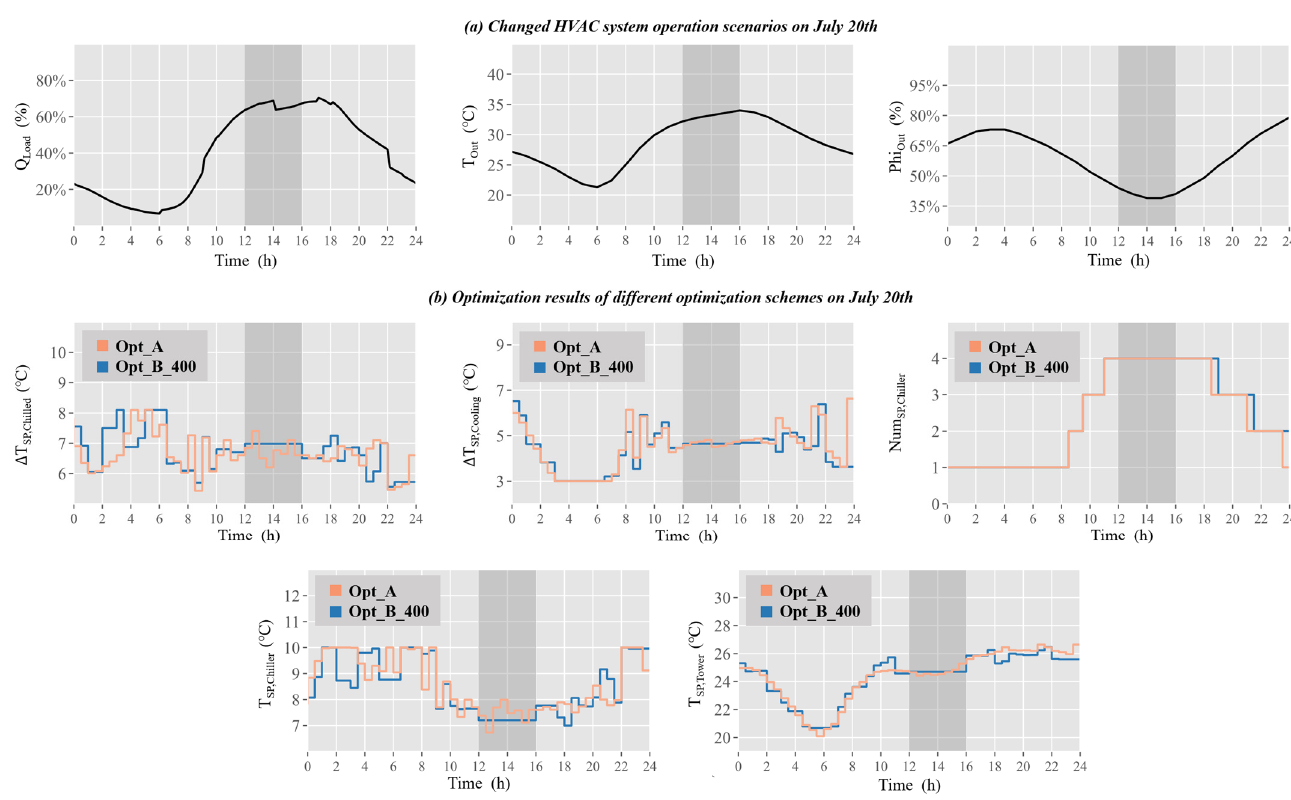
Figure 11. Simulation results under different optimization schemes on 20 July. To investigate the effect of the clustering approach on the setpoints, we selected all the operation scenarios represented by the dark gray area in Figure 11 from the simulated data of the entire cooling season, and analyzed their setpoints. Figure 12 shows the composition of the operation scenarios before and after clustering, and the changes in the optimal setpoints under these scenarios. Part (a) shows the differences between typical operation scenarios and the similar scenarios that the typical ones represent, while Part (b) shows the differences in the optimal setpoints under these operation scenarios. From the figure, it can be seen that, on the one hand, the difference between typical operation scenarios and their similar scenarios is relatively small, with less than 1 ◦ C in outdoor dry bulb temperature and less than 3% in both the outdoor relative humidity and cooling load ratio. On the other hand, the optimal setpoints for both types of scenarios also show certain similarities, with the difference in optimal setpoints for continuous variables within 1 ◦ C and the optimal setpoints for discrete variables remaining consistent.